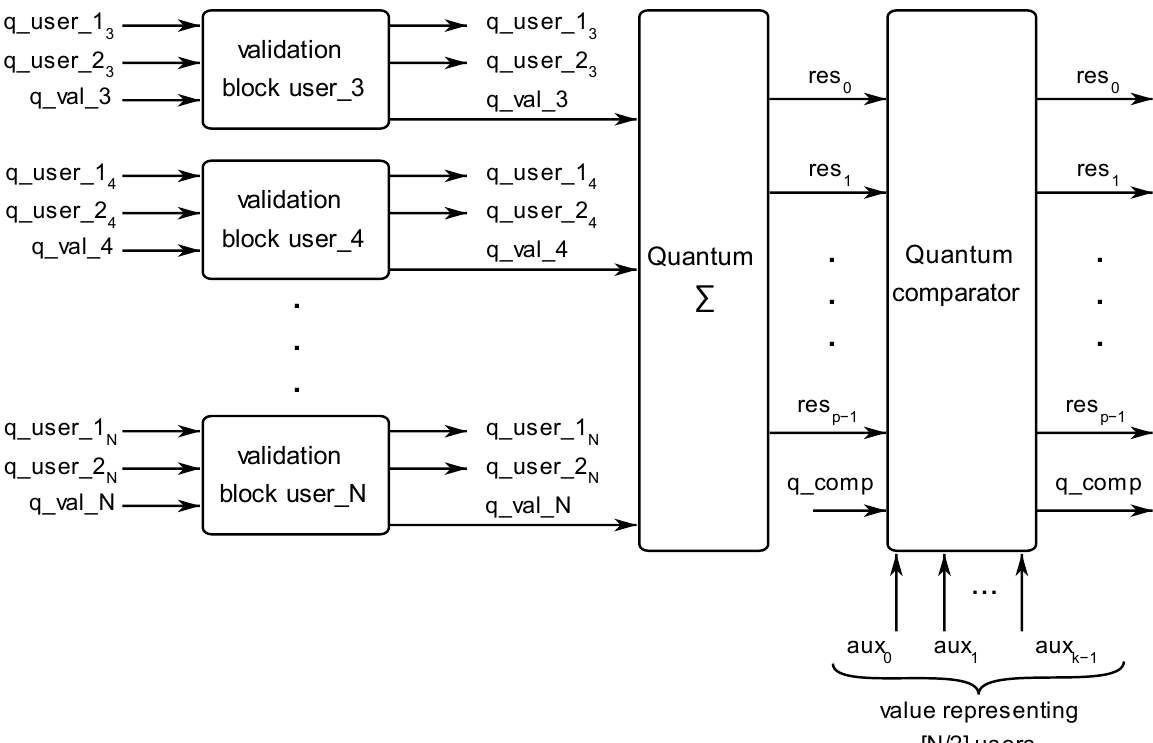
Figure 3. Schematic of the validation process for a transfer between user_1 and user_2.